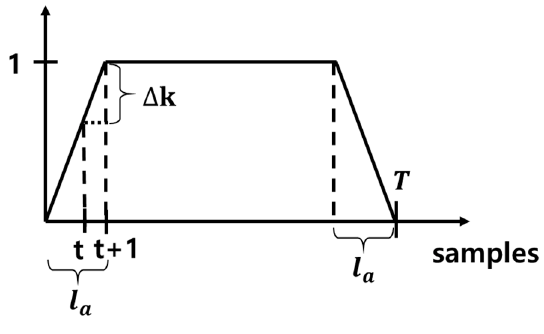
Figure 3. Window function.